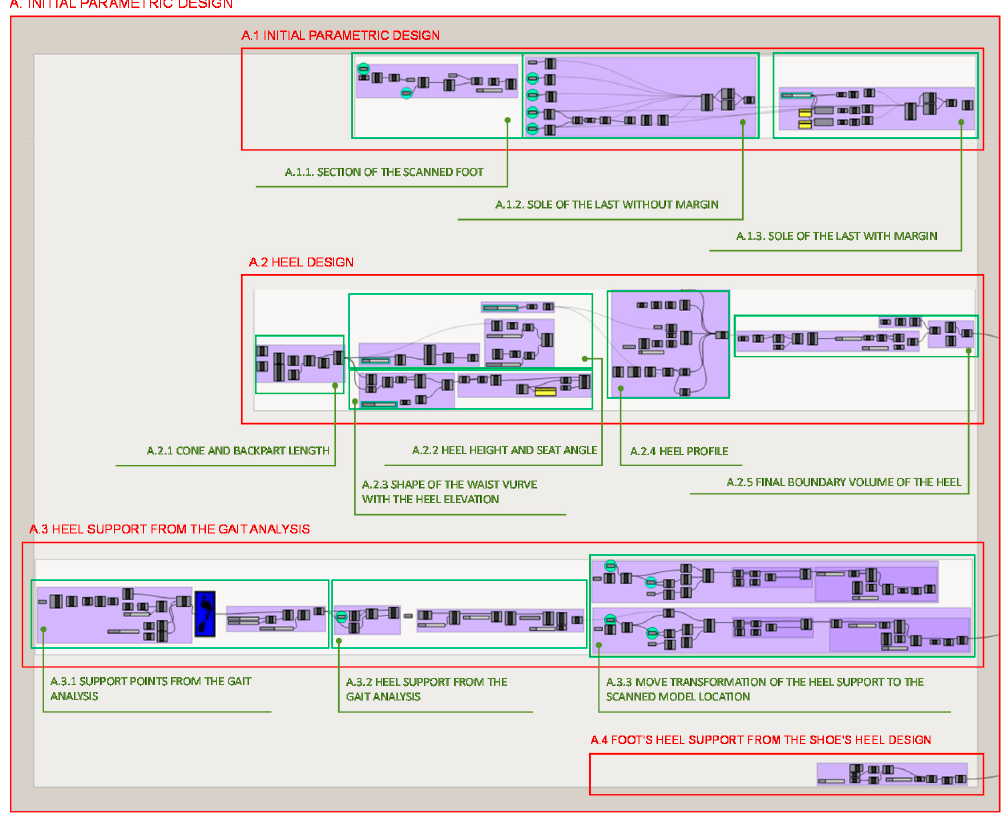
Figure 5. Programming structure definition of the initial parametric design of the heel volume.